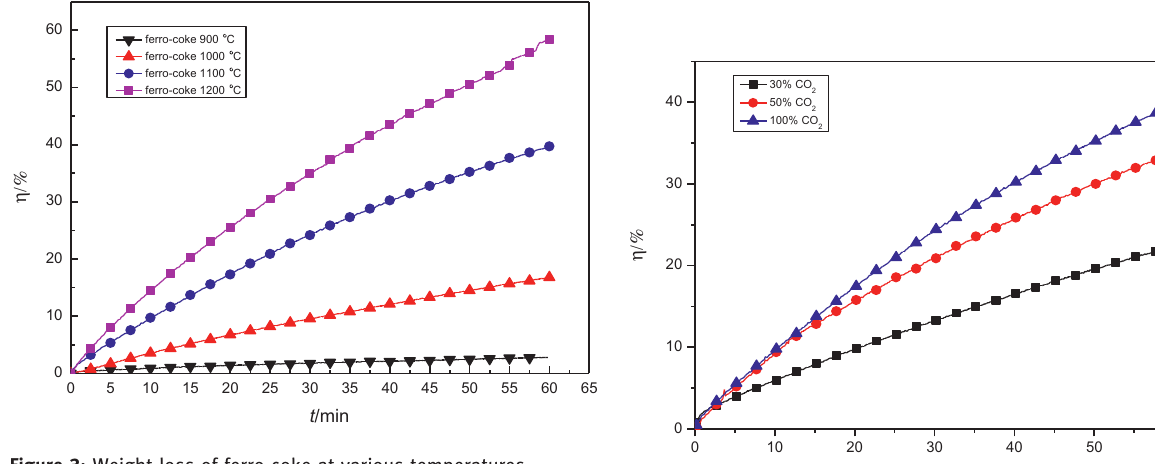
Figure 3: Weight loss of ferro-coke at various temperatures.